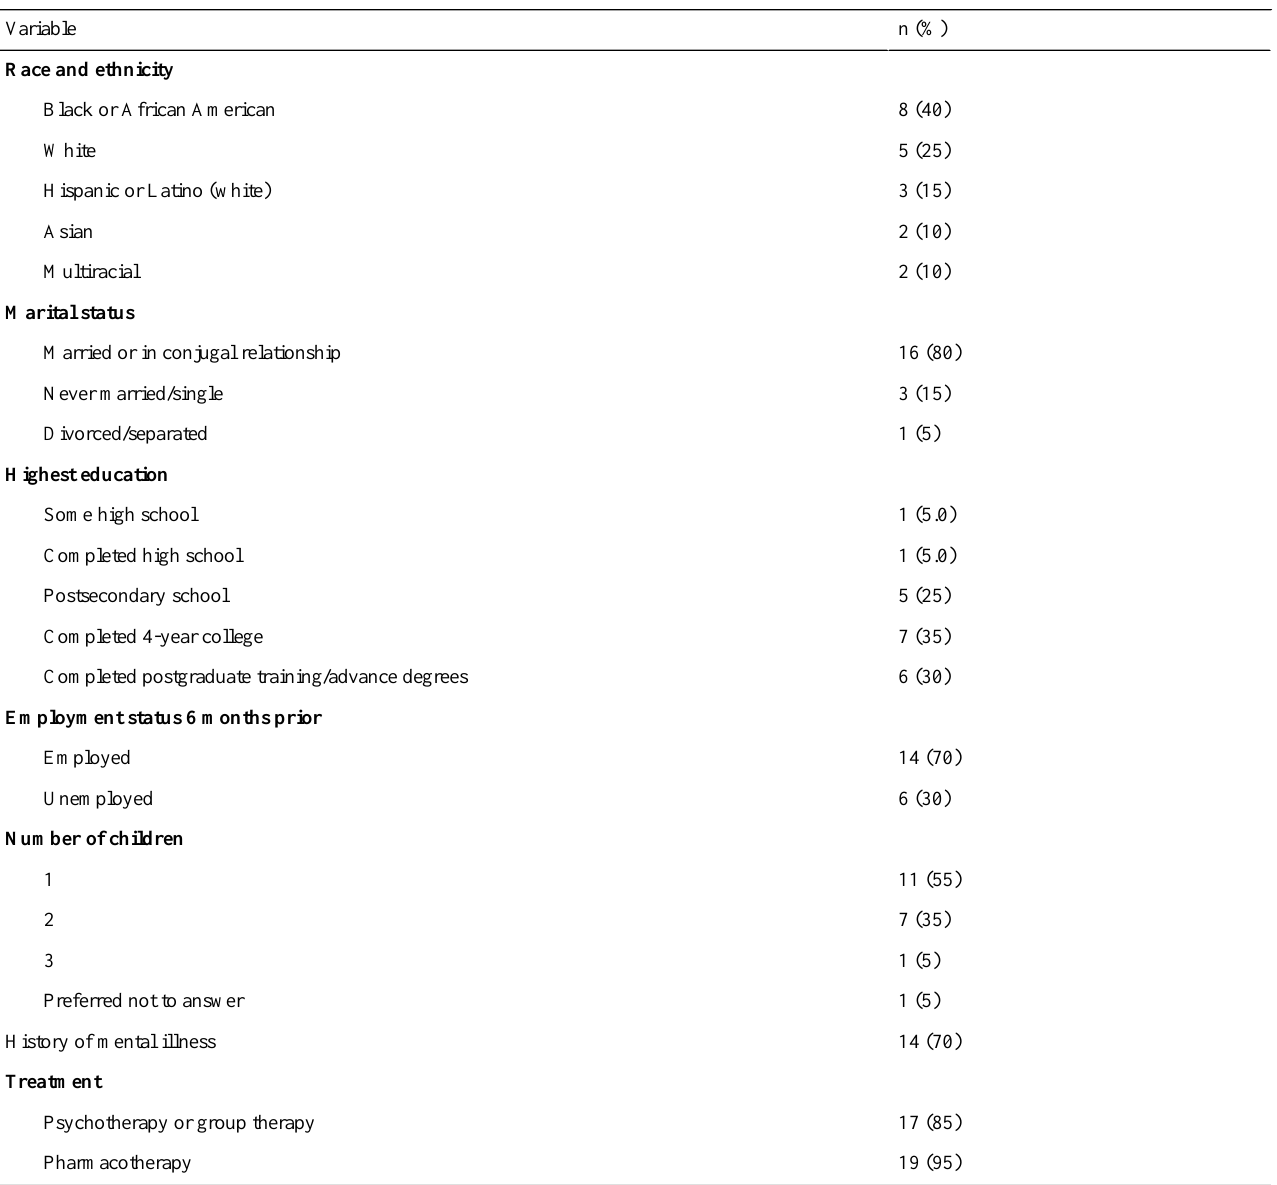
Table 1. Sample characteristics (n=20).